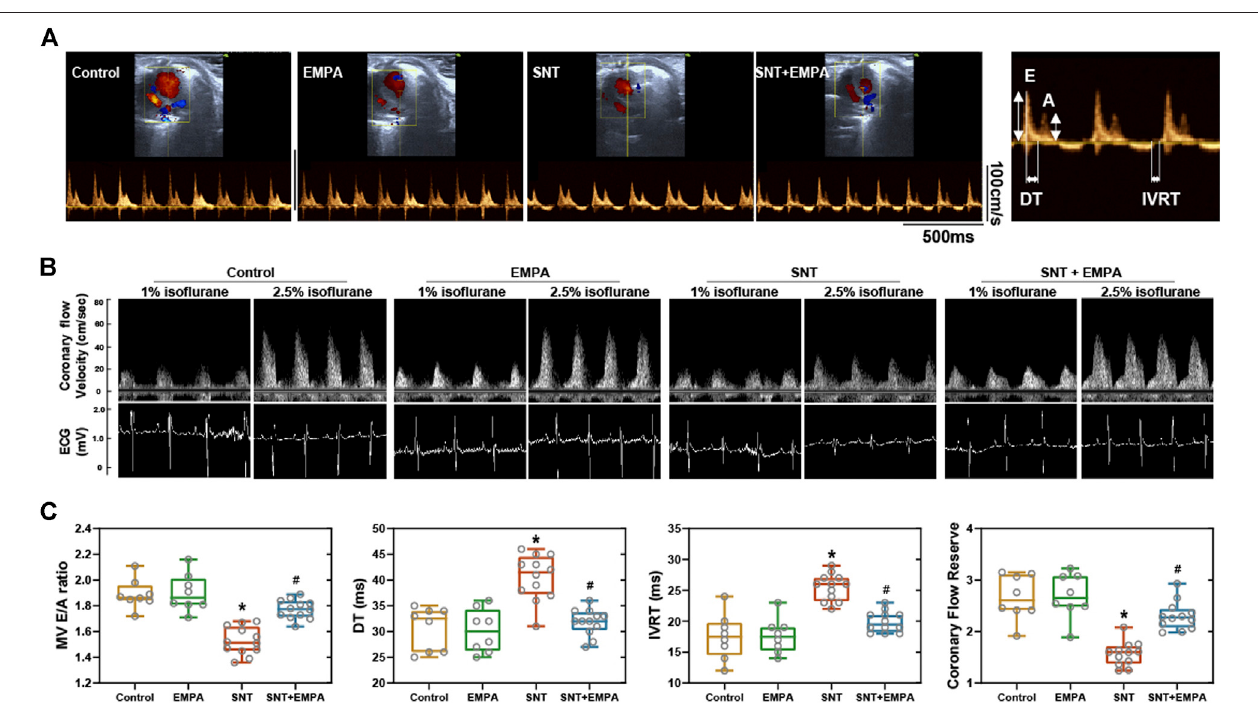
FIGURE3| EffectsofEMPAonleftventriculardiastolicfunctionandcoronary fl owreserveinSNT-treatedmice. (A) Representativerecordingsofmitralvalvein fl ow by pulsed wave Doppler in an apical four-chamber view at the study endpoint among different groups, n (cid:1) 8 or 12 per group. (B) Left ventricular diastolic function parameters evaluated from mitral valve fl ow spectrum among different groups, n (cid:1) 8 or 12 per group. (C) Representative ultrasound tracings of dilated (induced with 2.5% iso fl urane) and basal (with 1% iso fl urane) coronary fl ow at the study endpoint. (D) Quanti fi cation of coronary fl ow reserve (dilated/basal fl ow) among different groups, n (cid:1) 8 or 12 per group. * p < 0.05 vs. Control, # p < 0.05 vs. SNT.